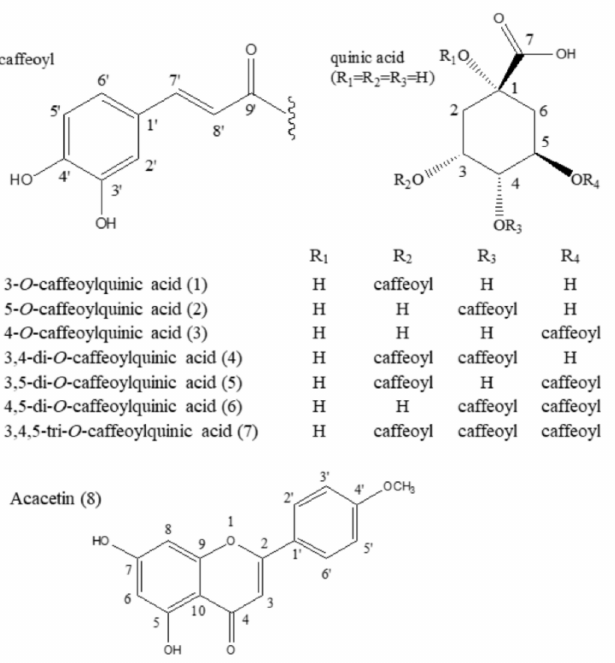
Figure 5. The structures of the components separated from the 70% MeOH root extract of V. rigida .